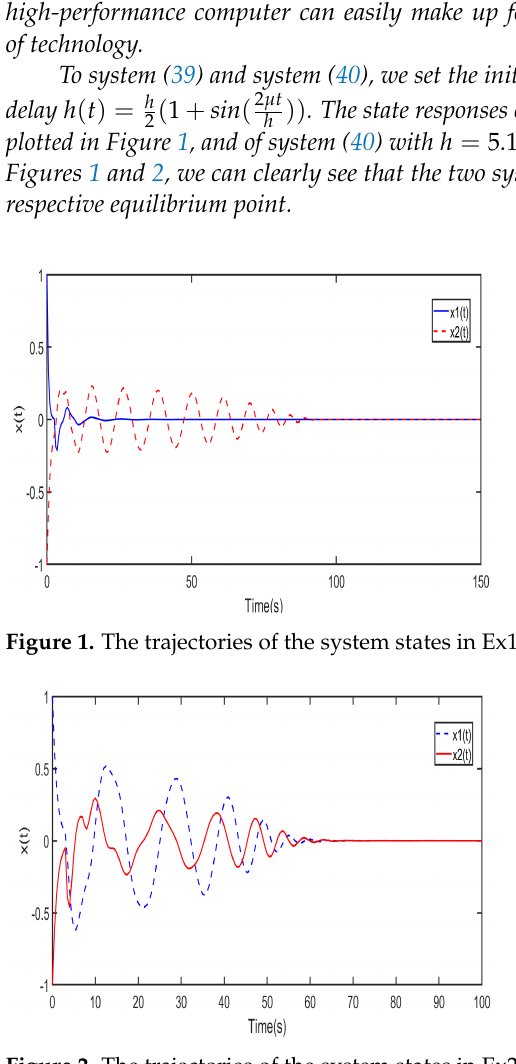
Figure 2. The trajectories of the system states in